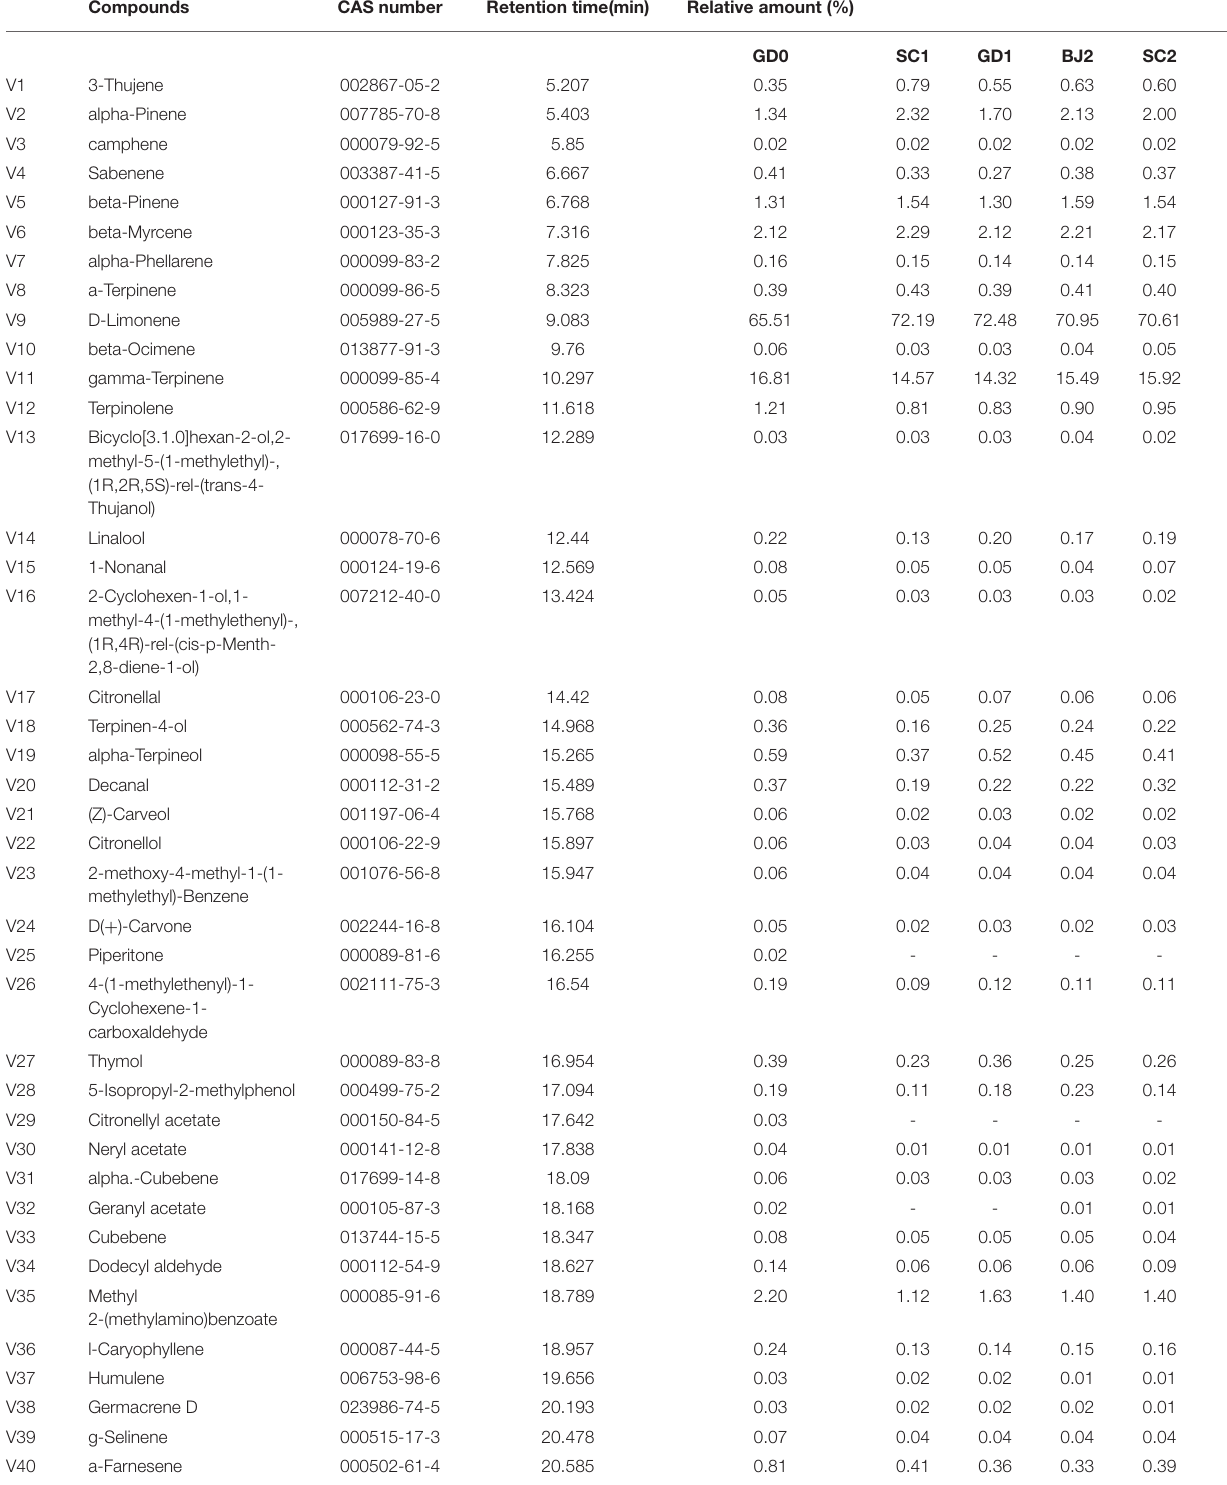
TABLE 5 | Volatile compounds of Citrus reticulata “Chachi” samples.